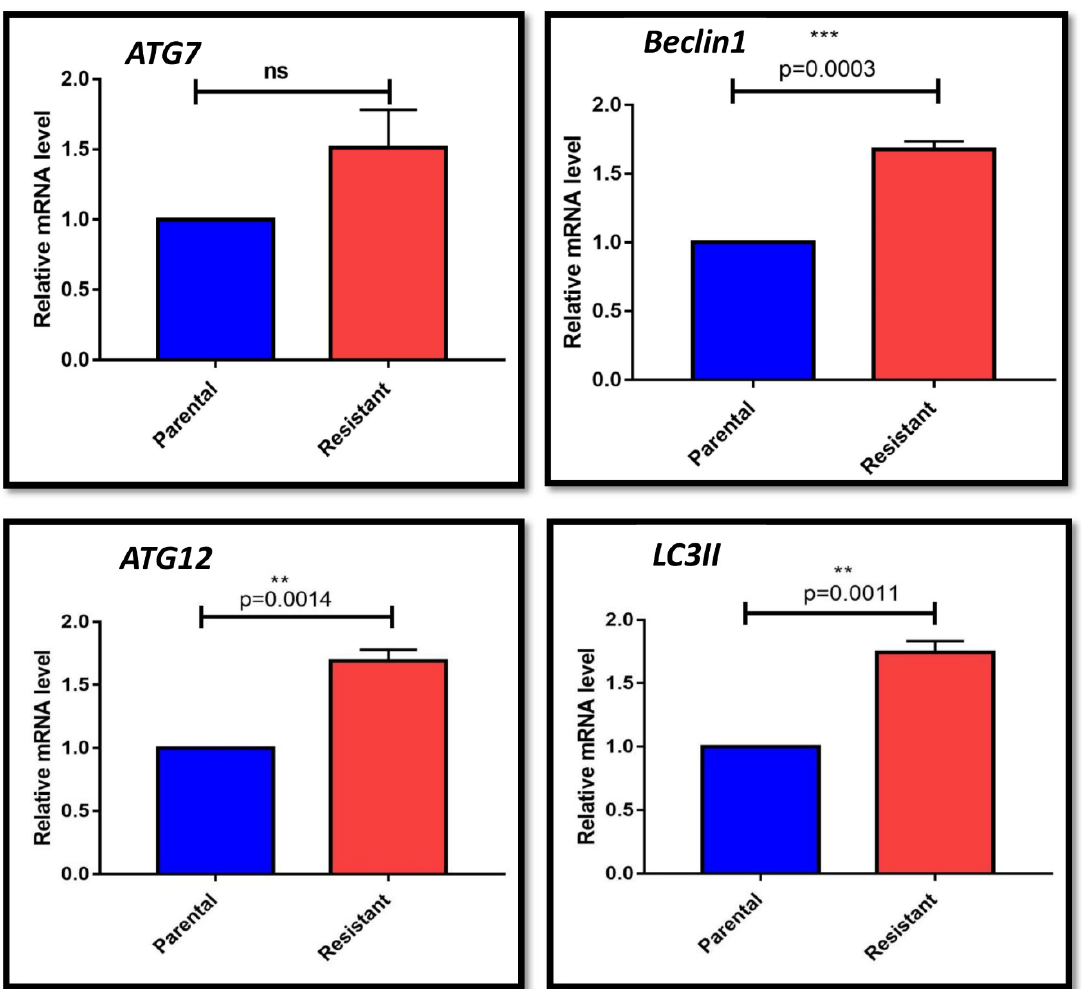
Figure 1. Bar graph representation of expression analysis of autophagy genes (Parental: Parental HepG2 cells; Resistant: Sorafenib resistant HepG2 cells) (ns: non-significant, p > 0.05; ** p ≤ 0.01; *** p ≤ 0.001) .